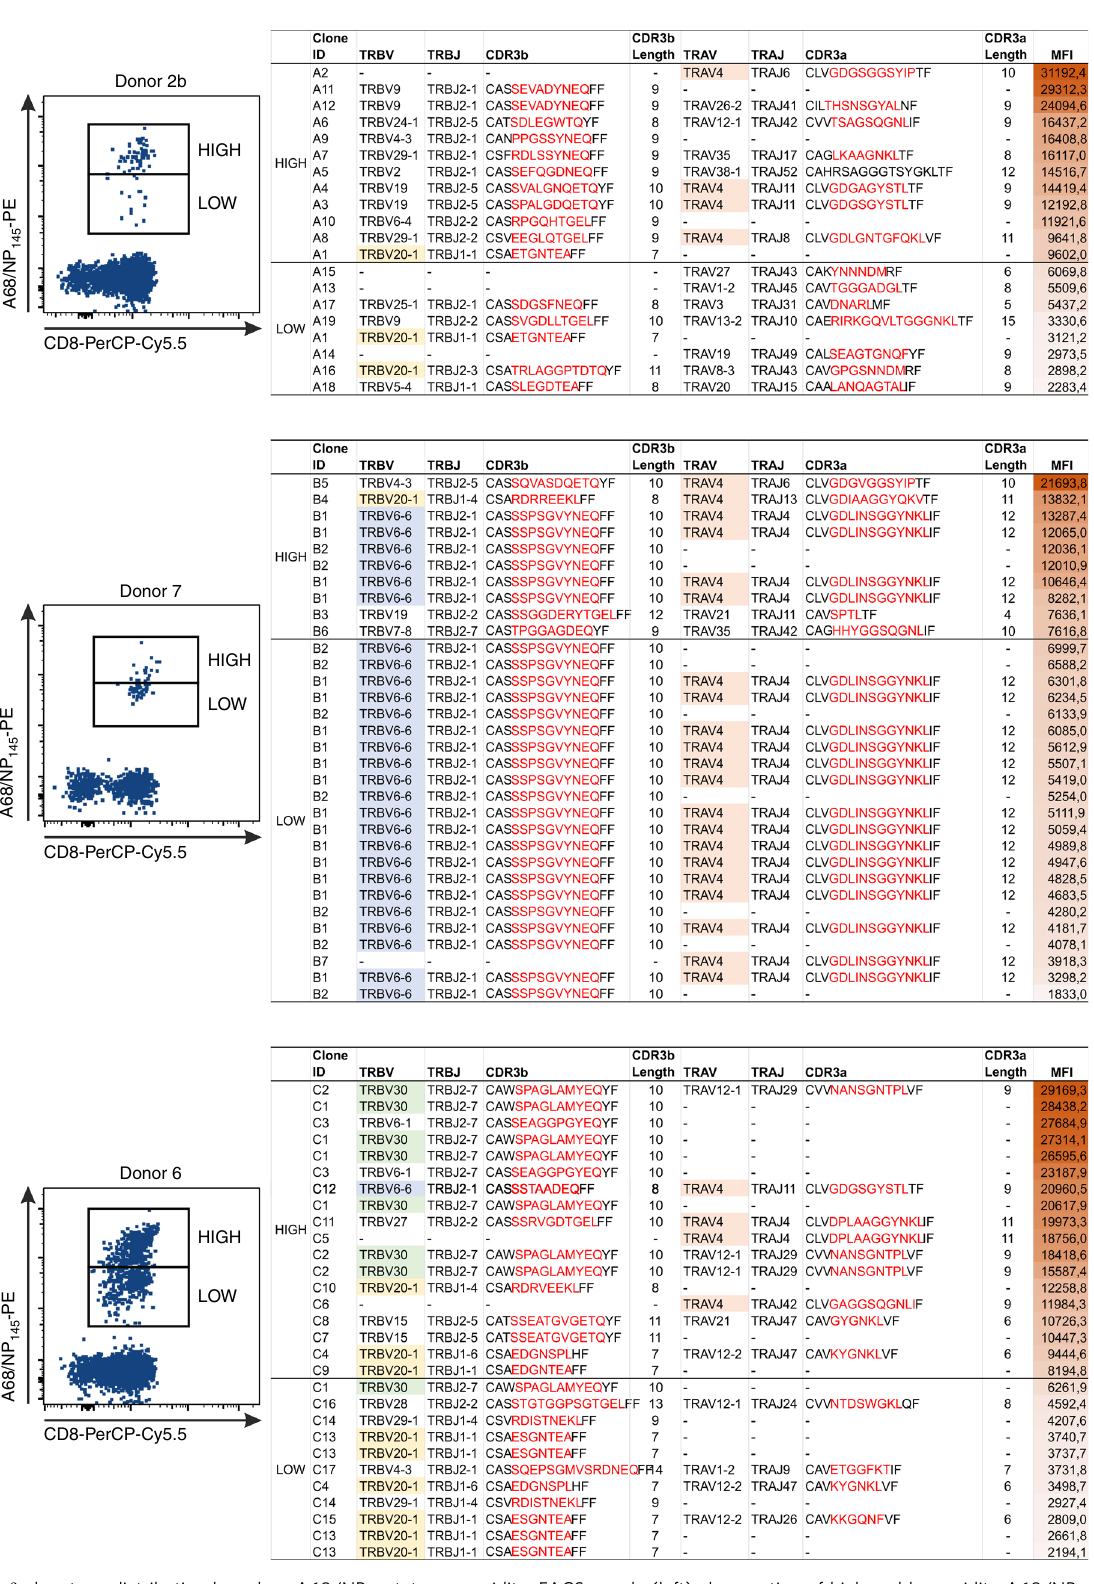
Fig. 7 TCR αβ clonotype distribution based on A68/NP 145 -tetramer avidity. FACS panels (left) show gating of high and low avidity A68/NP 145 + CD8 + T cells of low (donor 2b) and medium (donor 7 and 6) responders. Tables show clonotypes arranged based on A68/NP 145 – tetramer avidity (right). Last column in the table shows MFI of individual clonotypes, MFI gradient color from high MFI (dark red) to low MFI (white). TRBV20-1 (yellow) and TRAV4 (orange) are commonly observed clonotypes that are shared between donors, whereas TRBV6-6 (blue) and TRBV30 (green) are donor-speci fi c clonotypes observed at high